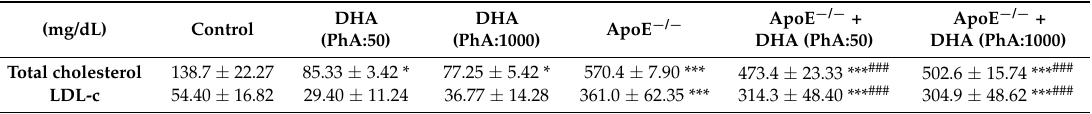
Table 1. Effects of DHA (PhA:50) and DHA (PhA:1000) on serum concentrations of total cholesterol and low-density lipoprotein cholesterol (LDL c) in ApoE − / − and wild-type mice.